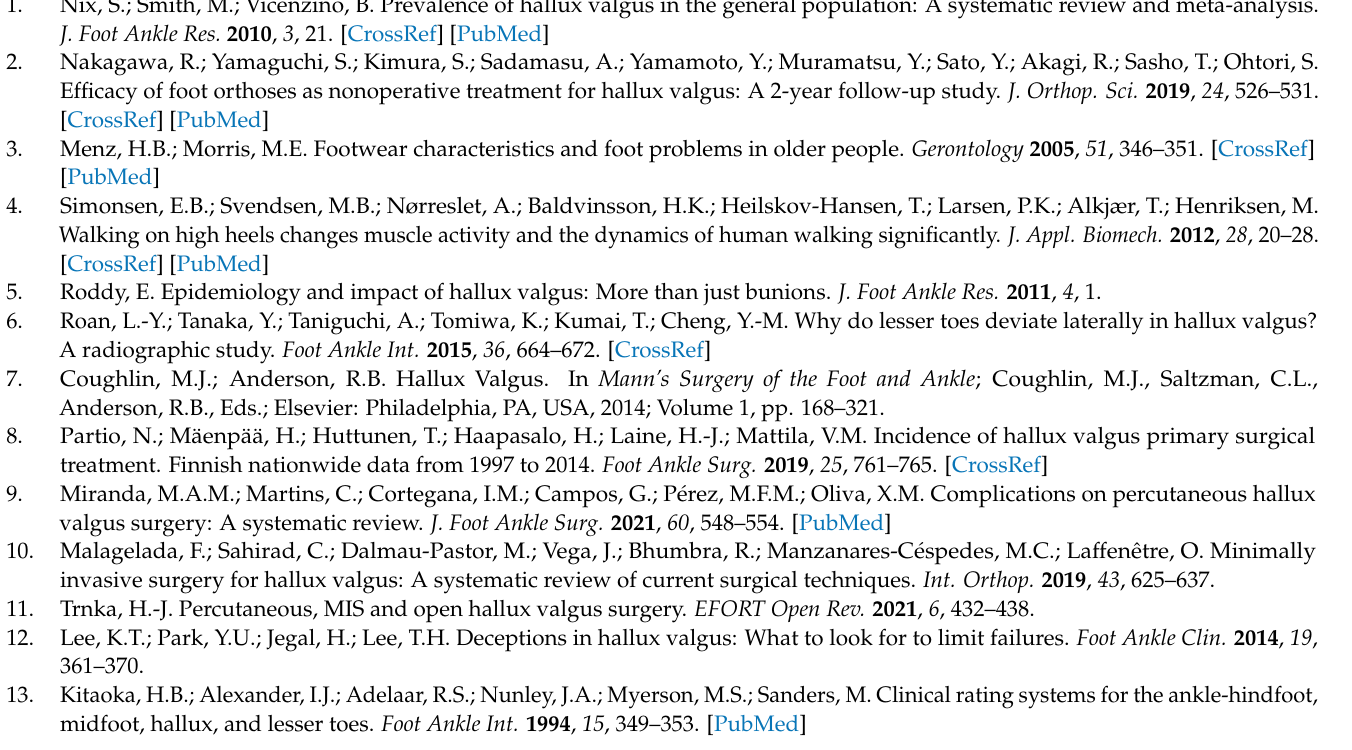
Figure S2: Meta-analysis on the overall effects of surgeries on plantar impulse (load time-integral) over medial metatarsal region (increase means better); Figure S3: Meta-analysis on the overall effects of surgeries on plantar impulse (load time-integral) over central metatarsal region (decreases means better). Table S1: Search terms and strategy in the systematic review; Table S2: Methodological quality assessment using NIH quality assessment tool for before-after